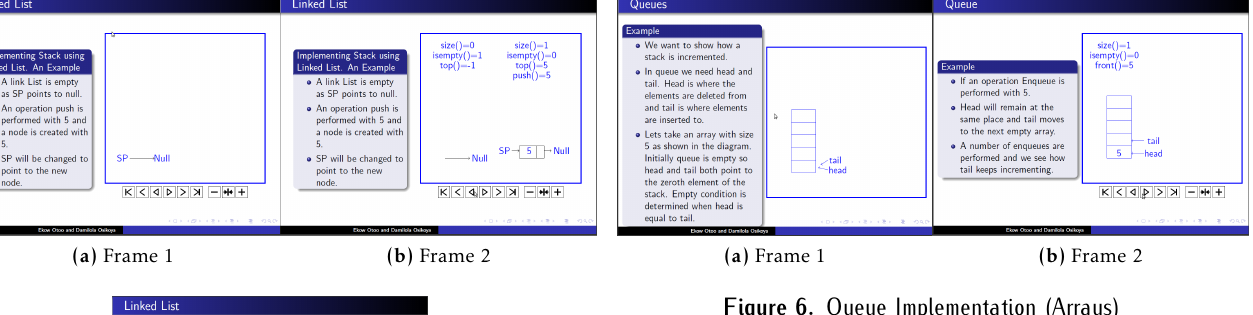
Figure 6. Queue Implementation (Arrays)